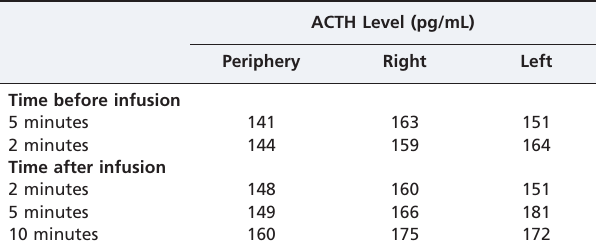
Figure 1 - Computerized tomography of the bronchial carcinoid.